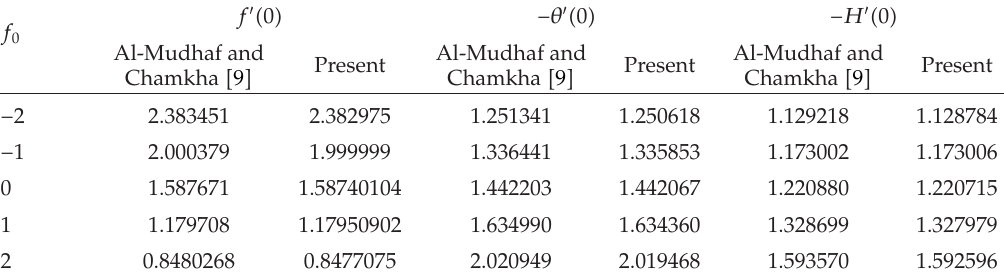
Table 2: Comparison values of f (cid:5) (cid:5) 0 (cid:6) , − θ (cid:5) (cid:5) 0 (cid:6) and − H (cid:5) (cid:5) 0 (cid:6) with di ff erent parameter f 0 .